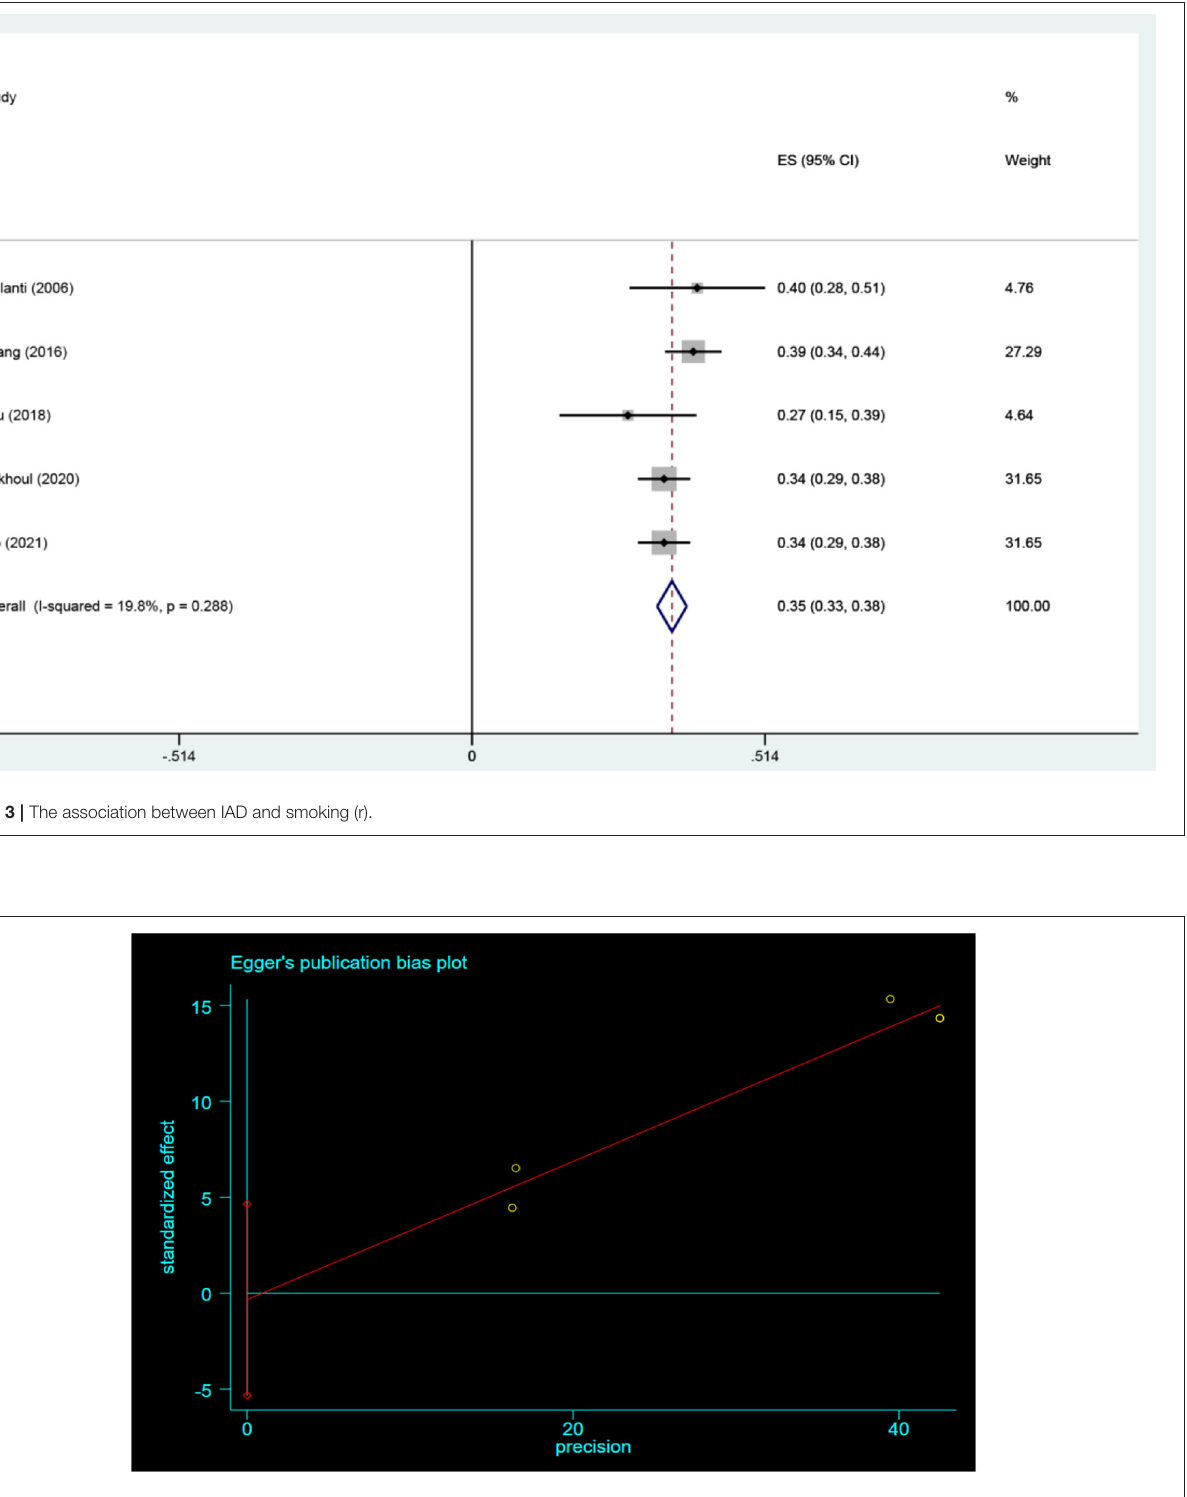
Frontiers in Public Health |